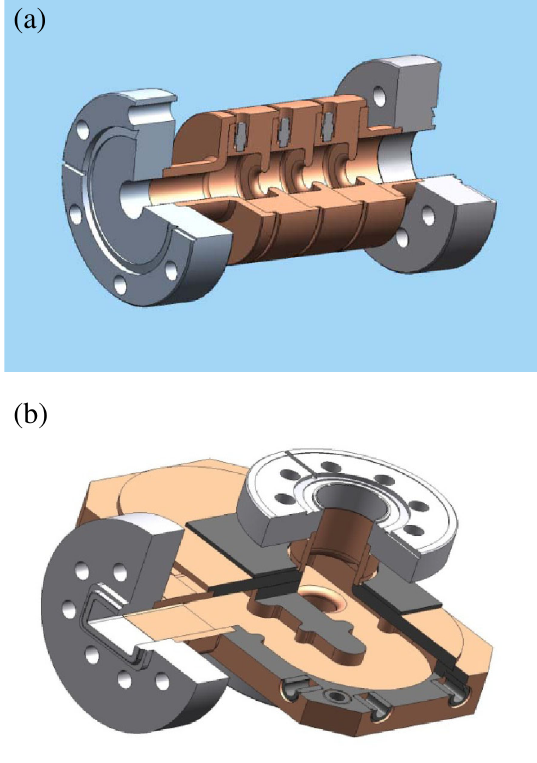
FIG. 1. Cutaway views of the ‘‘single cell’’ SW cavity (a) and the TM 01 mode launcher